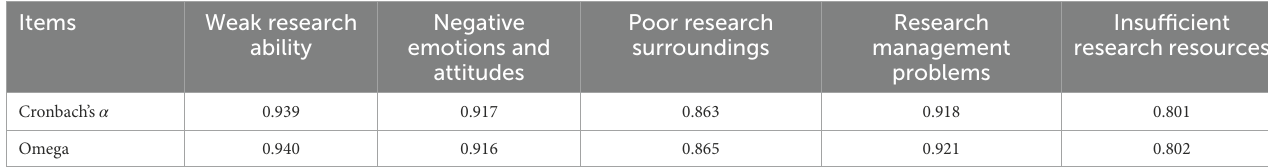
TABLE 5 Cronbach alpha and omega coefficients for the five factors. Items Weak research ability